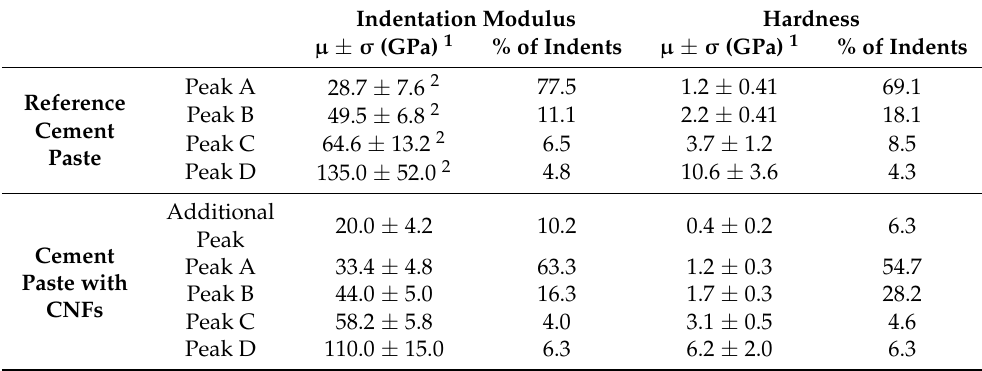
Table 1. Mean values of the indentation modulus and hardness and percent of indents for each mechanically distinct peak identified for the reference cement paste and the cement paste with